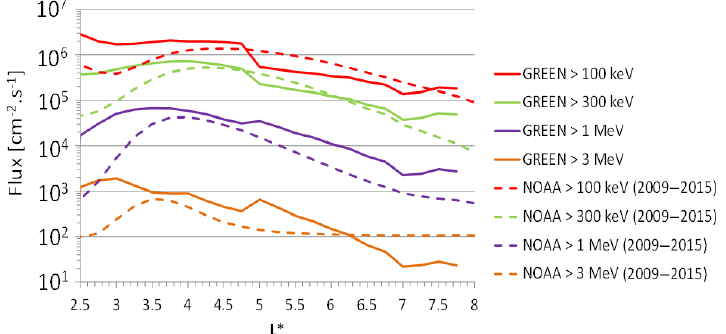
Figure 18. Mean electron fluxes in LEO orbit between 2009 and 2015 from NOAA-POES measurements (in dashed lines) and from GREEN- e (in full lines) for several energy channels.